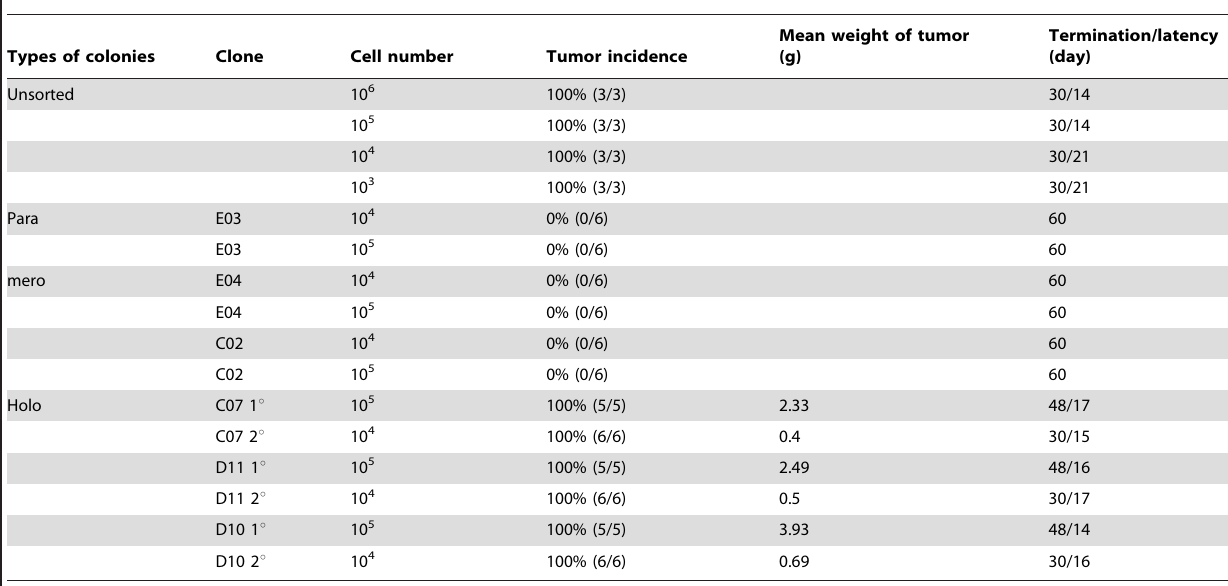
Table 1. Tumorgenecity of distinct types of